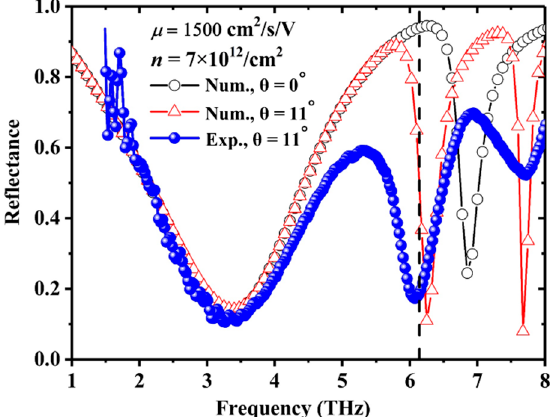
Figure 2. Experimental and numerical reflection spectra of the MGDM-graphene structure with θ the incident angles. The optimized fitting parameters of carrier mobility and carrier concentration are μ = 1500 cm 2 /s/V and n = 7 × 10 12 /cm 2 , respectively. The vertical dashed line at about 6.1 THz represents the first diffractive mode frequency of the grating.